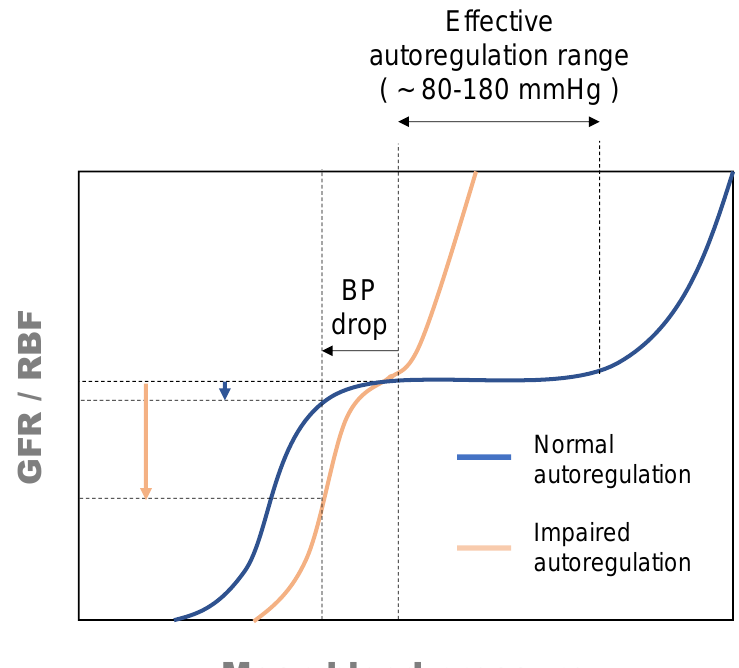
Figure 4. Relation between blood pressure (i.e., renal perfusion pressure) and glomerular filtration rate or renal blood flow under normal and impaired autoregulation conditions indicating that, under impaired autoregulation, the effect of a drop in blood pressure (BP) on glomerular filtration rate (GFR) or renal blood flow (RBF) is magnified, compared to the effect observed under normal autoregulation conditions [95].